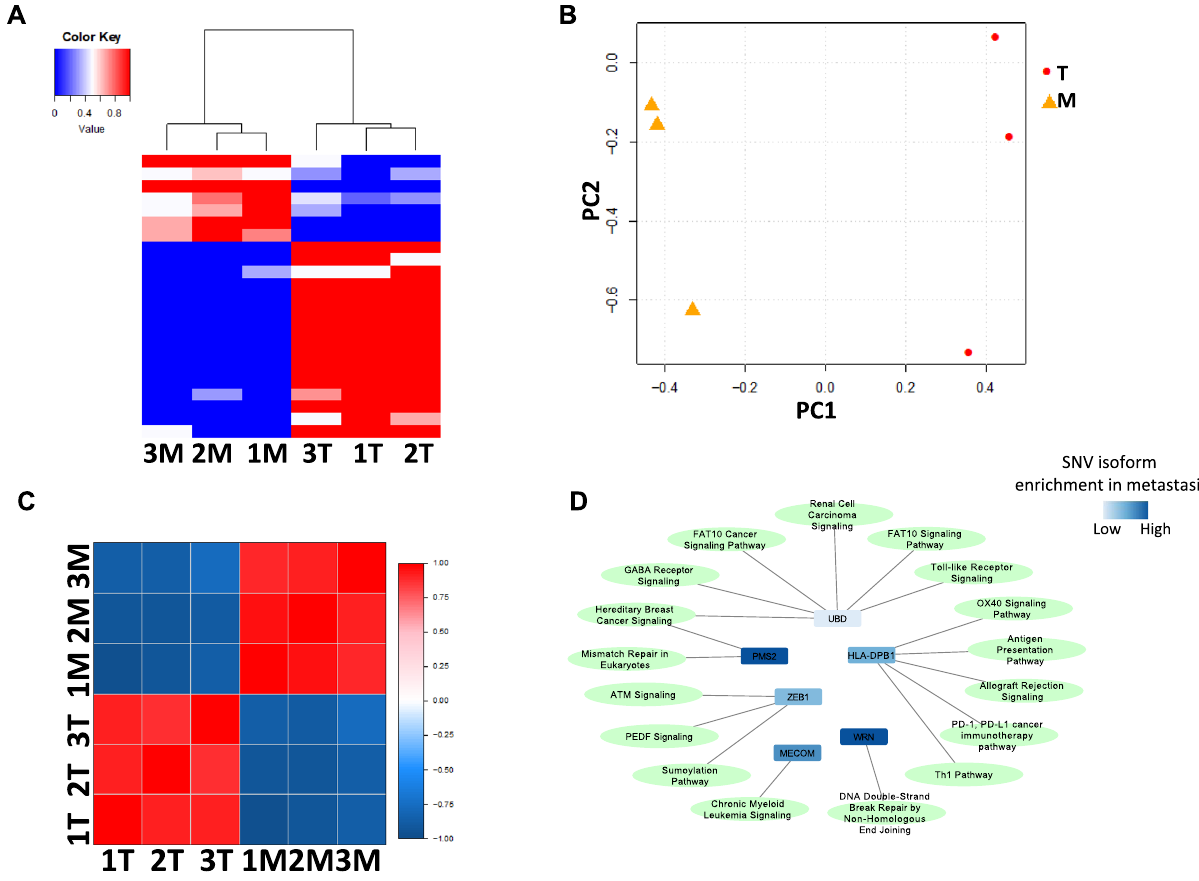
Fig. 3 Isoform switches of single-nucleotide variant between primary colon cancers and metastatic colon cancers. A Hierarchical clustering between primary colon cancers and metastatic colon cancers based on the quantities of non-synonymous SNVs of 23 isoforms in each sample. The color re fl ects SNV rate by fraction. B Principal component analyses of primary colon cancers and metastatic colon cancers based on the quantities of non-synonymous SNVs of ( A ). C Pearson ’ s correlation of primary colon cancers and metastatic colon cancers based on the quantities of non-synonymous SNVs of ( A ). The color re fl ects Pearson ’ s correlation coef fi cient for the pairing samples. D Pathway analysis of 23 single-nucleotide-variant isoforms showed enrichment in genes involved in HLA/CD74 antigen presentation pathways.